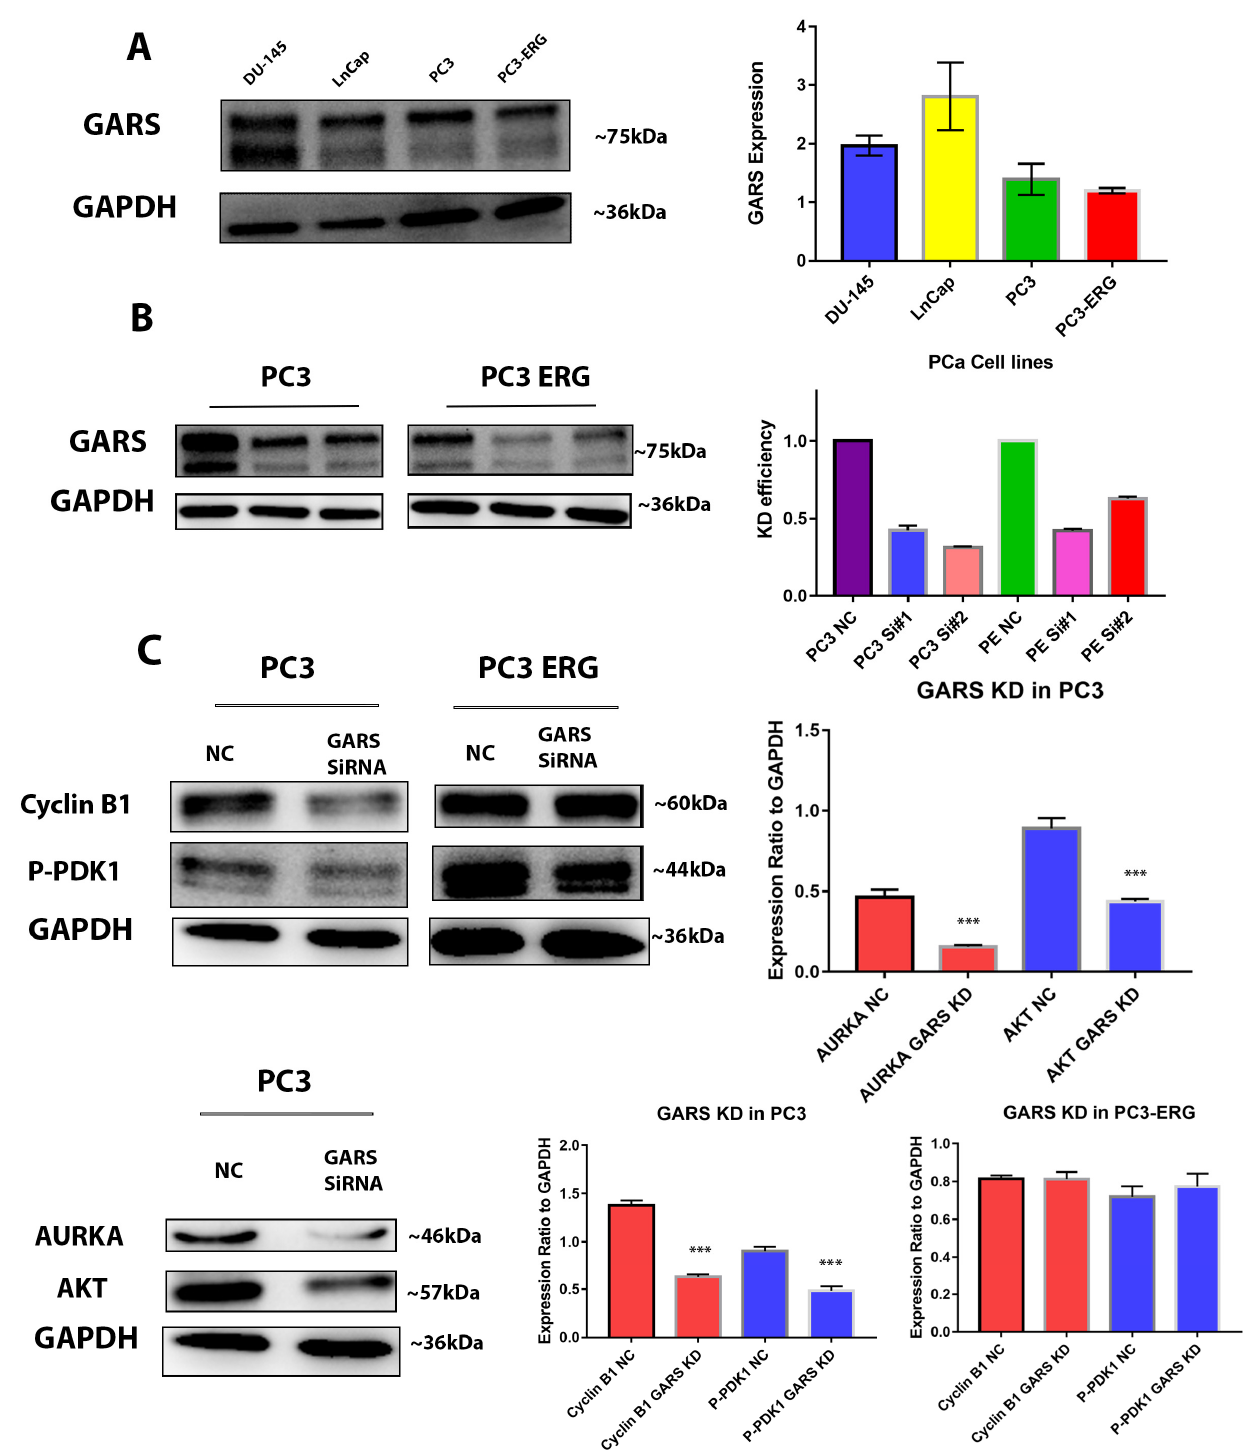
Figure 6. Western blot analysis of GARs in PCa cell line. ( A ) Western blot of GARS expression in PCa cell lines: DU-145, LnCap, PC3, and PC3-ERG cells. ( B ) GARS Knockdown efficiency in PC3 and PC3-ERG cell lines using GARS siRNA#1, #2, and scrambled siRNA as negative control after 48 h. ( C ) Western blotting analysis of Cyclin B1, P-PDK1, AURKA, and AKT proteins expression in GARS knockdown PC3 and PC3-ERG cells compared to negative control cells. GAPDH was used as internal housekeeping control (*** Asterisks indicate significant p value < 0.0001).